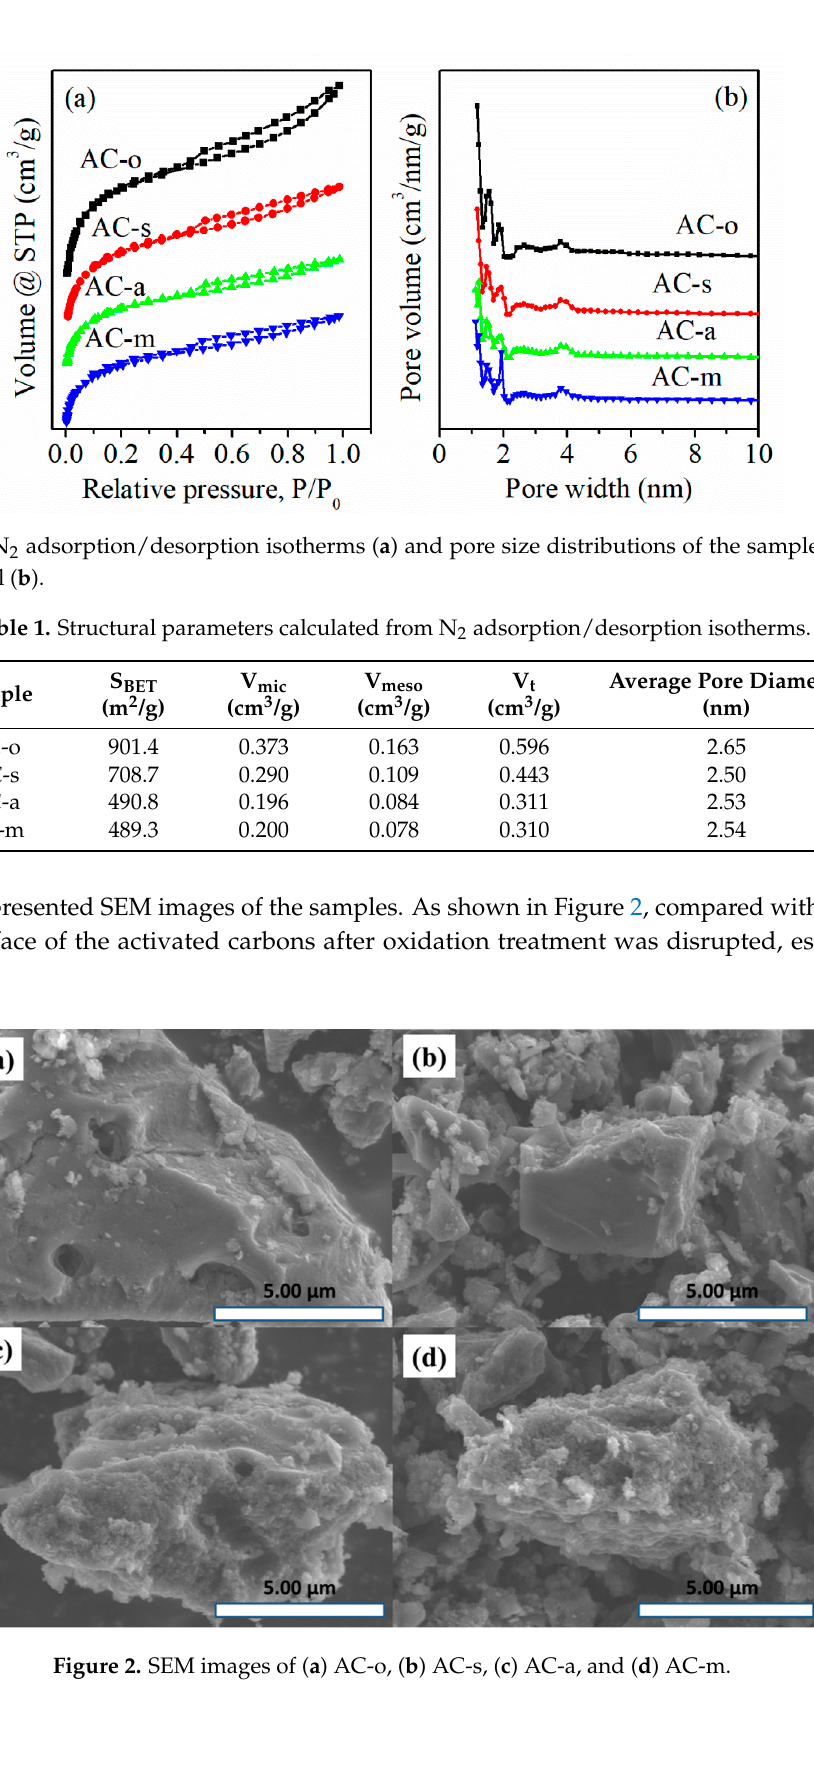
Table 1. Structural parameters calculated from N 2 adsorption/desorption isotherms. Sample